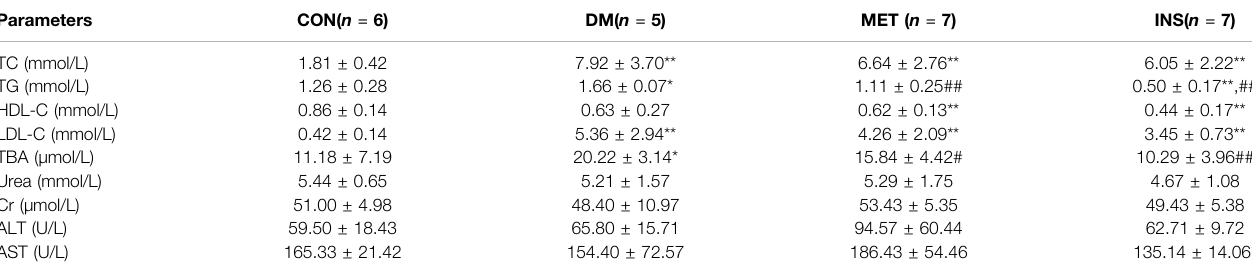
TABLE 1 | Biochemical parameters.